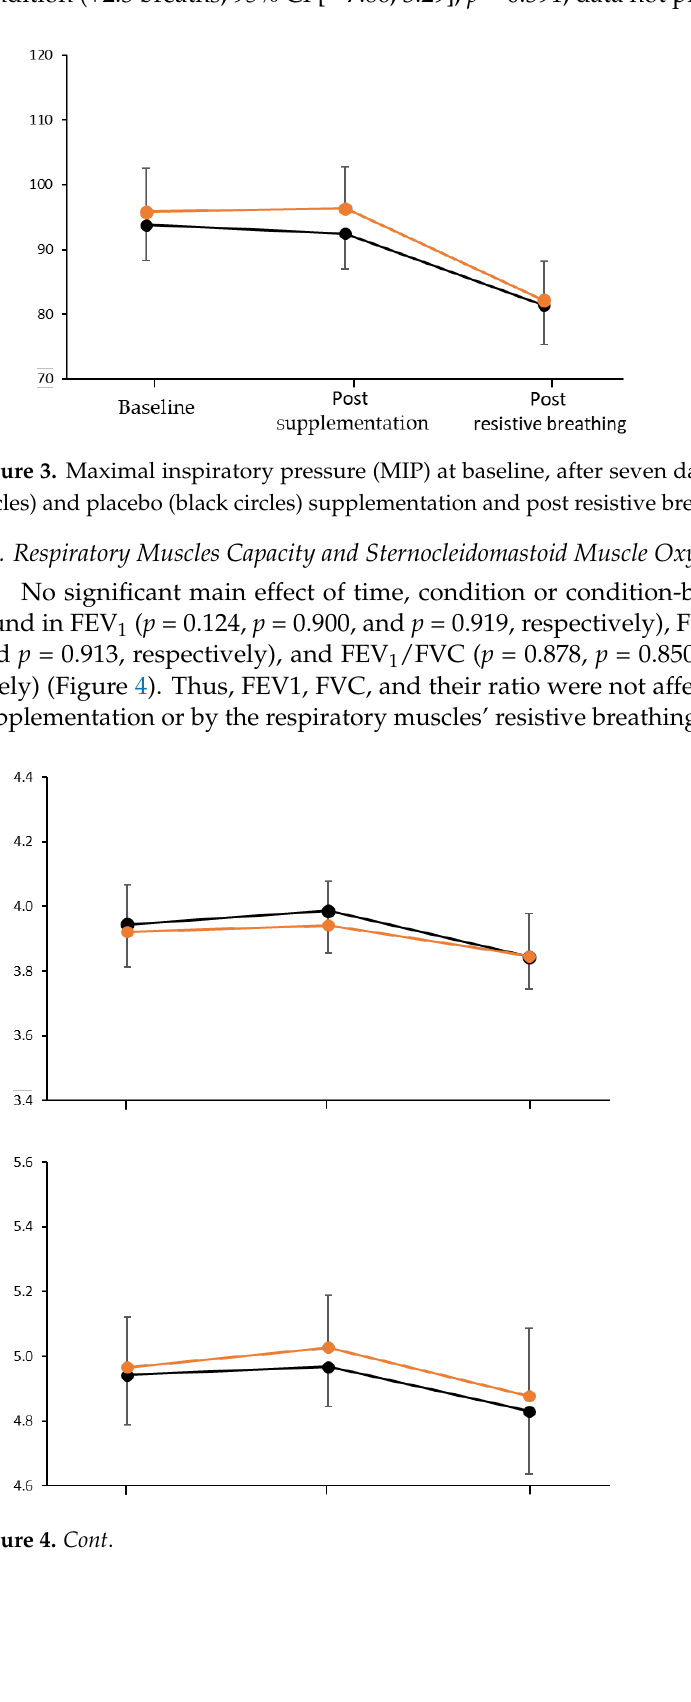
Figure 4. Forced expired volume in 1 second ( A ), forced vital capacity ( B ), and their ratio ( C ) at baseline, after seven days of L-citrulline (orange circles) and placebo (black circles) supplementation and post resistive breathing to task failure. Concerning muscle oxygenation, neither a main effect of condition nor a condition by time interaction was found in Δ[O 2 Hb] ( p = 0.591 and p = 0 .815, respectively), Δ[HHb] ( p = 0.902 and p = 0.653, respectively), Δ[tHb] ( p = 0.684 and p = 0.708, respectively), and TSI% ( p = 0.782 and p = 0.524, respectively) between L-citrulline and the placebo measured in sternocleidomastoid muscles (Figure 5A – D). Nevertheless, a significant main effect of time was found for Δ[O 2 Hb] ( p < 0 .001), Δ[HHb] ( p < 0.001), and TSI% ( p < 0.001). More specifically, the resistive breathing intensity stages of 80% and 90% MIP caused a Δ[O 2 Hb] decrease in both the L-citrulline (at 80%: −3.71 μΜ; 95% CI [−7 .11, −0 .31,] and at 90%: −6 .69 μΜ; 95% CI [−1 0.72, −2 .68]) and placebo (at 80%: −4.78 μΜ; 95% CI [−8 .18, −1 .37] and at 90%: −6.89 μΜ; 95% CI [−1 0.91, −2 .87]) conditions. Likewise, the breathing intensity stages of 80% and 90% MIP caused a TSI% decrease in both the L-citrulline (at 80%: −8 .4%; 95% CI [ −1 3.67, −3 .18] and at 90%: −7 .64%; 95% CI [ −1 3.74, −1 .55]) and placebo (at 80%: −5 .64%; 95% CI [ −1 0.89, −0 .39] and at 90%: −9 .57%; 95% CI [ −1 5.67, −3 .48]) conditions. Finally, a